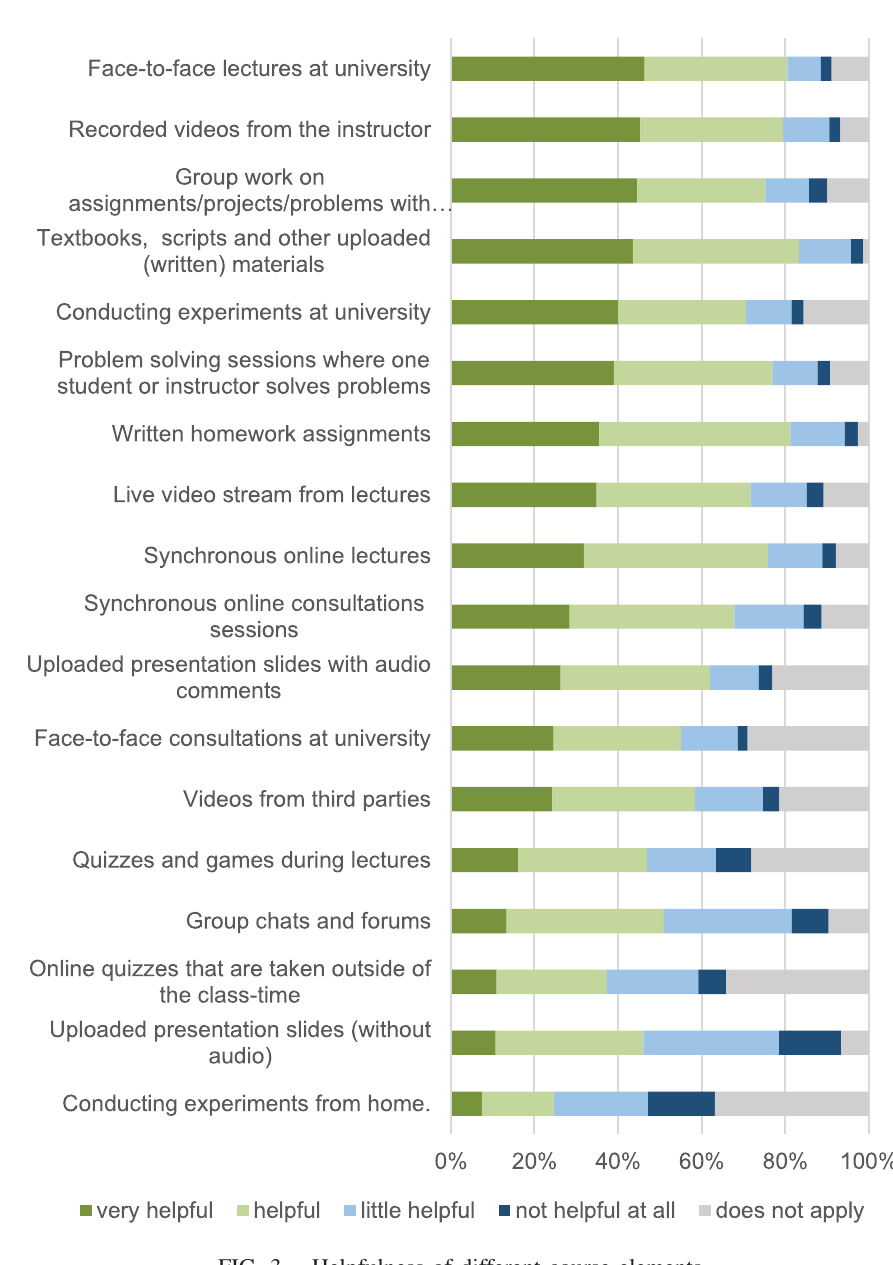
FIG. 3. Helpfulness of different course